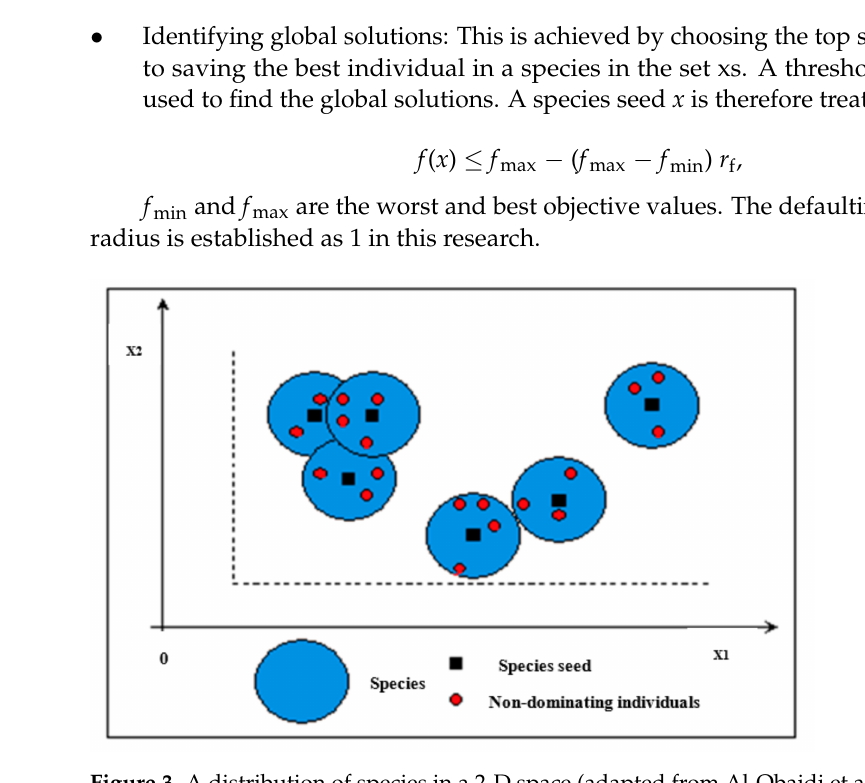
Figure 3. A distribution of species in a 2-D space (adapted from Al-Obaidi et al.